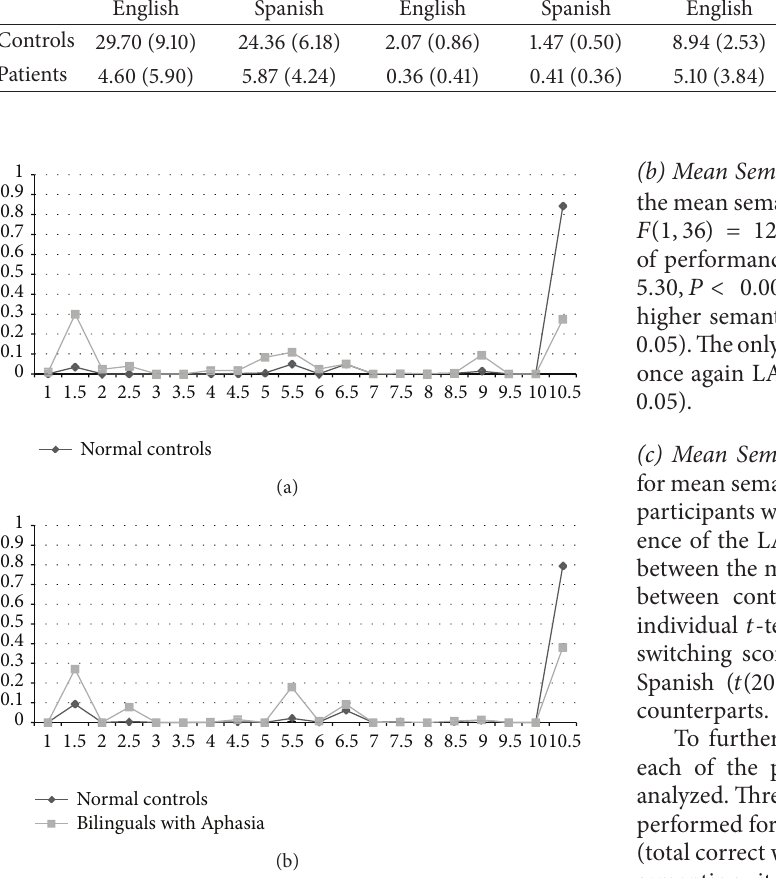
Figure 2: (a) Comparison between accurate production and errors on BPNT for normal controls and bilinguals with aphasia on English targets. (b) Comparison between accurate production and errors on BPNT for normal controls and participants with aphasia on Spanish targets. Correct responses are scored 10.5 (Correct responses in TL). The greatest errors made being No response/idk in TL (1.5), Circumlocution in TL (5.5), Correct response in NTL (9). Error Percentages Spanish (across patients): (1) No response/idk